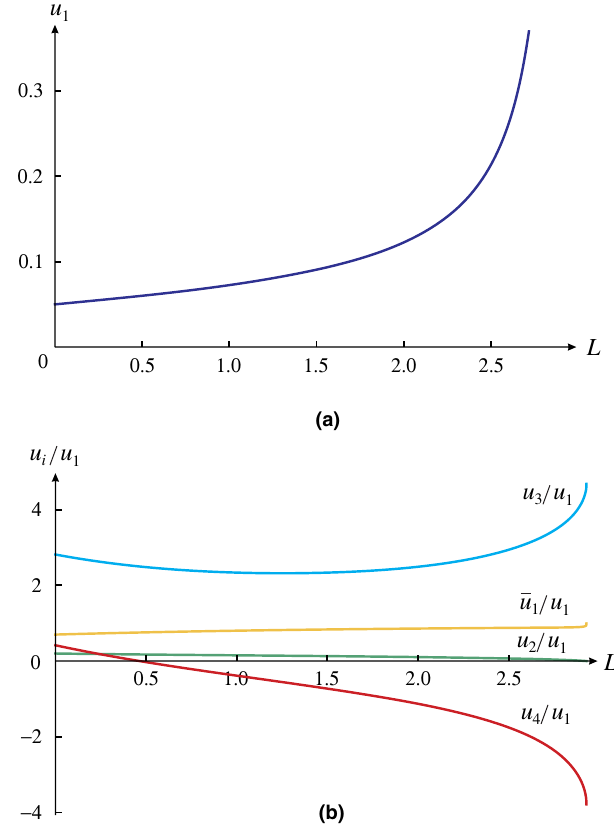
FIG. 2. RG flow of the couplings. (a) u 1 ð L Þ , where L ¼ log W=E is the RG scale, W is the bandwidth, and E is the running energy (temperature) at which one probes the system. The flow of other couplings is similar. The couplings u 1 − u 5 and ¯ u − ¯ u 1 = ð L − L Þ when L approaches L 1 5 all diverge as 0 value depends on the initial conditions. The couplings ~ u 4 , ~~ u 5 tend to zero at L → L 0 . (b) Flow of the ratios of the couplings. All ratios tend to fixed finite values as L approaches L 0 : ¯ u 1 ¼ u 1 , u 3 ¼ ¯ u 3 ¼ 4 . 7 u 1 , u 4 ¼ u 5 ¼ ¯ u 4 ¼ ¯ u 5 ¼ − 3 . 8 u 1 [see Eq. (11)]. The ratios u 2 =u 1 and ¯ u 2 =u 1 tend to zero as L approaches L 0 . The initial values used are ¯ u 1 =u 1 ¼ 0 . 7 , u 2 =u 1 ¼ 2 , u 3 =u 1 ¼ 2 . 8 , u 4 =u 1 ¼ 0 . 4 . In both panels, we set C ¼ ð m p ffiffiffiffiffiffiffiffiffiffiffiffi Þ ¼ 1 . 1 for definiteness. For the model with d ð 2 m m e h electron pockets, the fixed trajectory is the same, but the system approaches it much faster (see Sec.